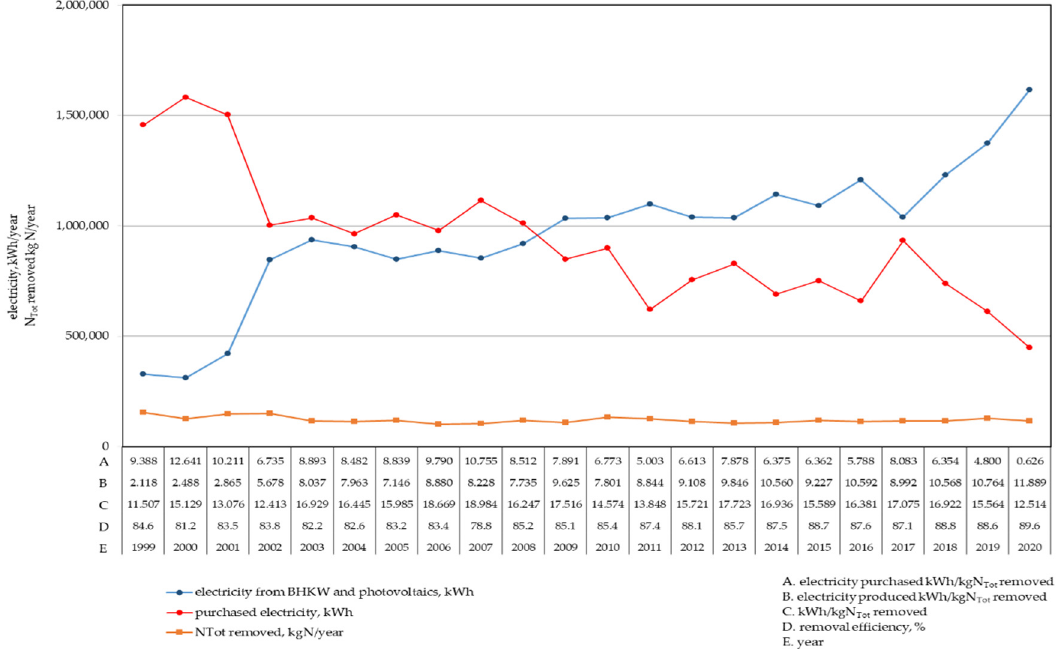
Figure 10. Amount of energy produced in BHKW and photovoltaic plant system, electricity purchased and total nitrogen removed in the years 2000–2020.